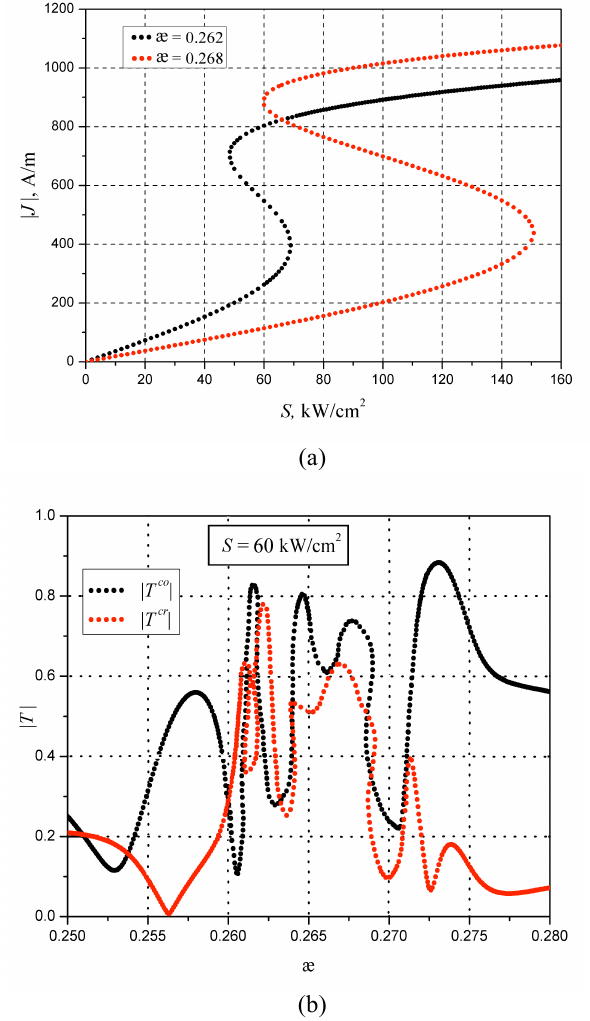
intencity (a) and transmission spectrum (b) of the array placed on an antiferromagnetic substrate, nonlinear